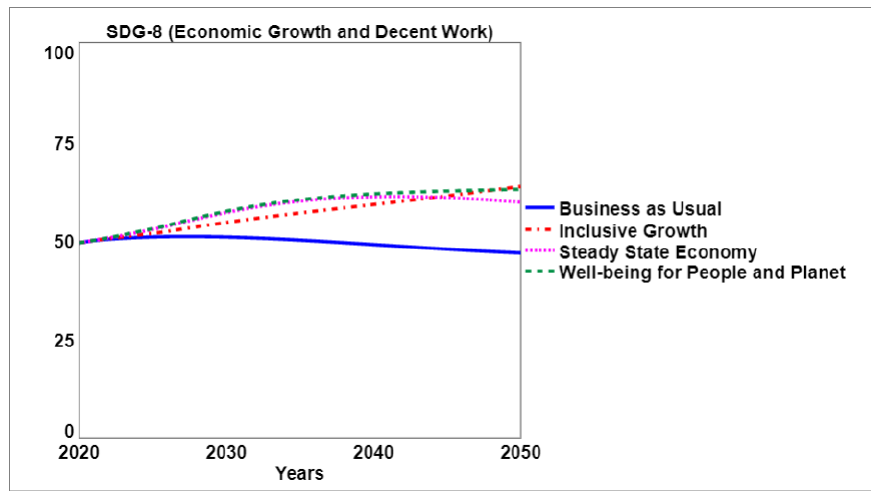
Figure 9. Implementation of SDG-8 in the four scenarios in Iran in the period 2020 to 2050.